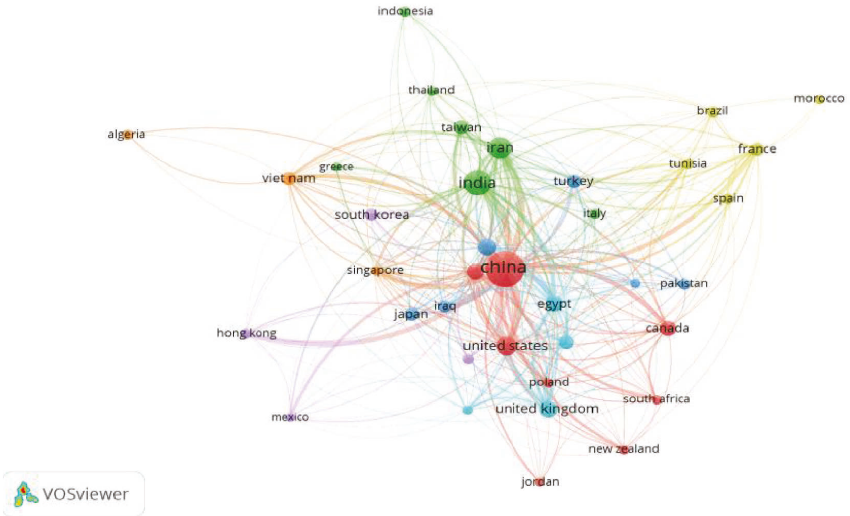
Figure 14: Network visualization map of the co-citations among most active countries researching PSOA topics.